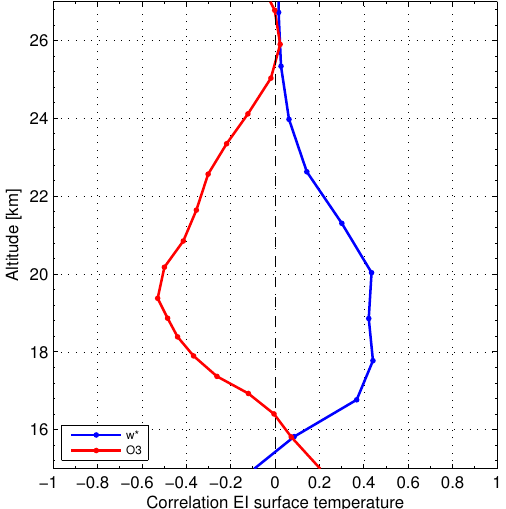
Figure 8. Correlation of EI surface temperature anomalies with anomalies of w ∗ calculated from EI all-sky heating rates and mod- elled O 3 mixing ratios in the tropics (20 ◦ N–20 ◦ S). The corre- sponding time series range from 01-1980 to